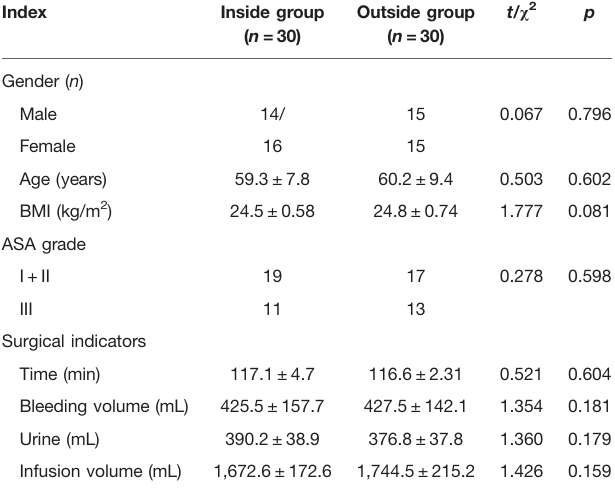
TABLE 1 | Comparison of demographic and surgical indicators between two groups.